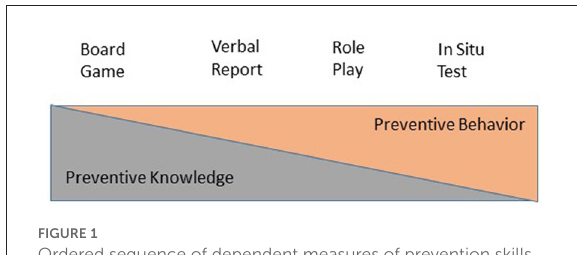
FIGURE1 Ordered sequence of dependent measures of prevention skills, composed of two theoretical